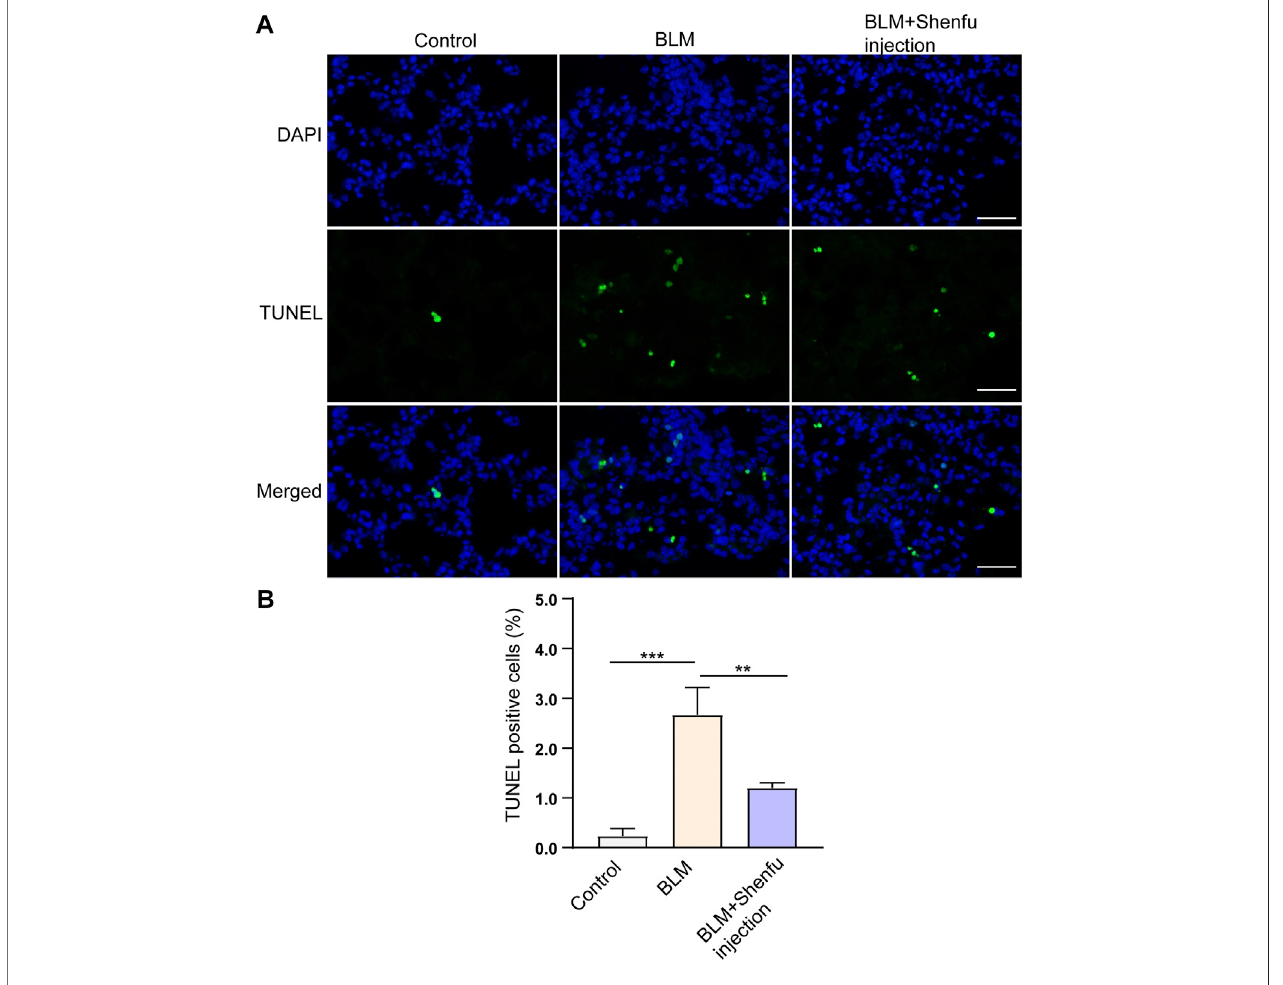
FIGURE 4 | Shenfu injection suppresses BLM-induced apoptosis. (A) Representative TUNEL staining using lung tissues 4 days after BLM treatment. (B) Quanti fi cation of TUNEL positive cells. Scale bar: 50 μ m. The results are expressed as mean ± SD ( n (cid:1) 3 mice per group). *** p < 0.001, ** p < 0.01.